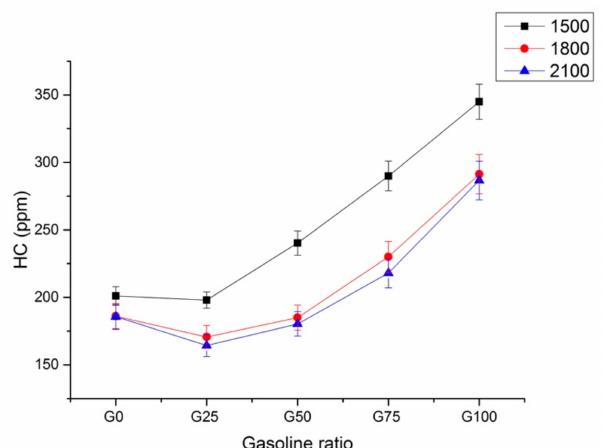
Figure 6. Hydrocarbon emissions with R e for di ff erent speed (The direct injection timing is 180 ◦ CA BTDC. The ignition timing is MBT. The intake manifold absolute pressure is 42